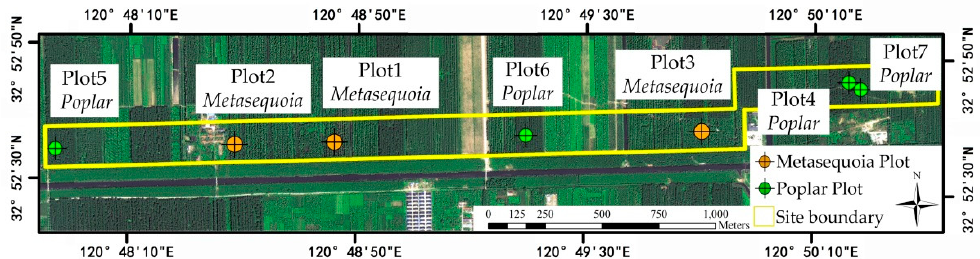
Figure 1. The study area and the spatial distribution of field plots.